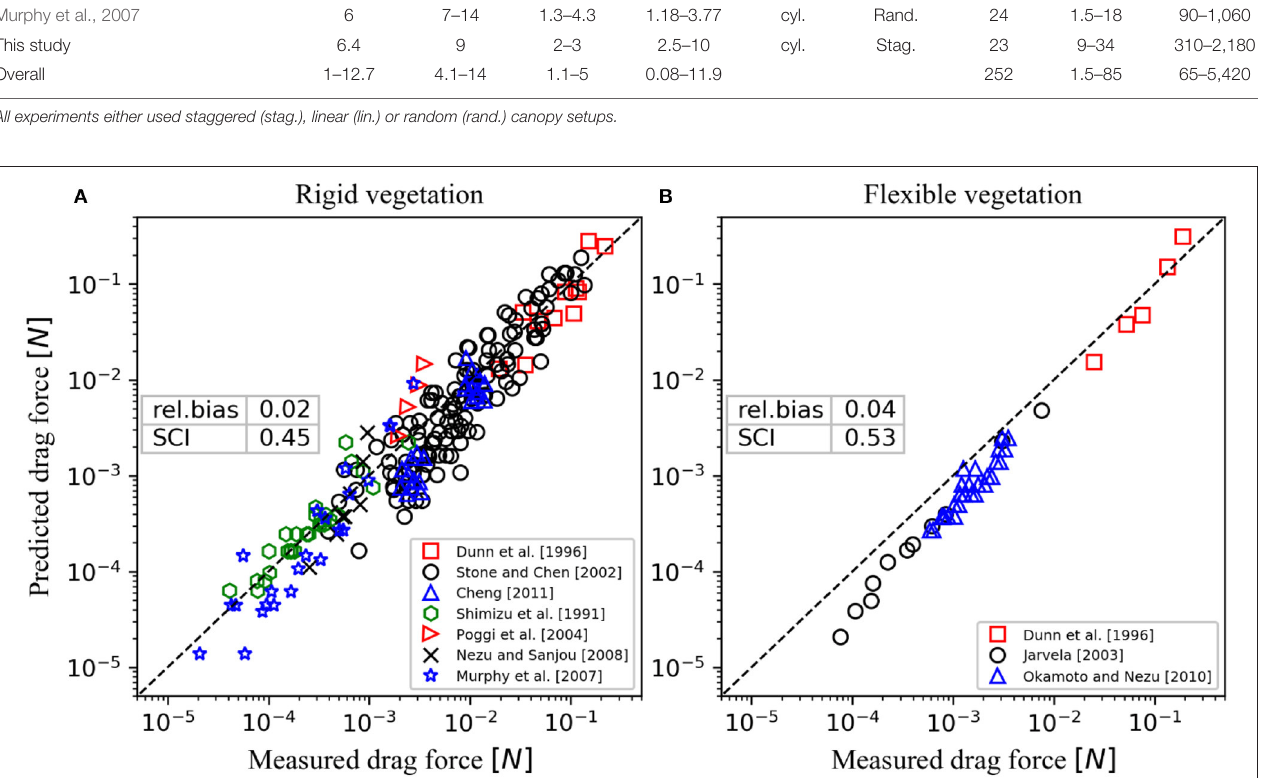
Frontiers in Marine Science |